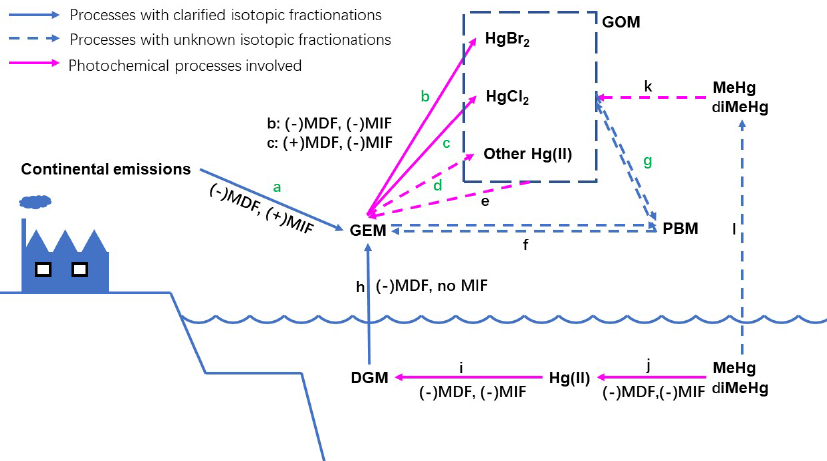
Figure 2. The atmospheric processes of Hg in the MBL with inducing isotopic fractionations (MDF and only odd-MIF directions). Process a: mixing with continental emissions; b: oxidation by Br atoms; c: oxidation by Cl atoms; d: oxidations by alternative oxidants; e: photoreduc- tions of gaseous Hg(II); f: adsorption and desorption of Hg 0 on airborne particle surfaces; g: adsorption and desorption of Hg(II) on airborne particle surfaces; h: volatilization of dissolved gaseous Hg 0 from surface sea water; i: photoreduction of aquatic Hg(II); j: photodecomposi- tion of aquatic MeHg / diMeHg; k: photodecomposition of gaseous MeHg / diMeHg; and l: volatilization of dissolved MeHg /